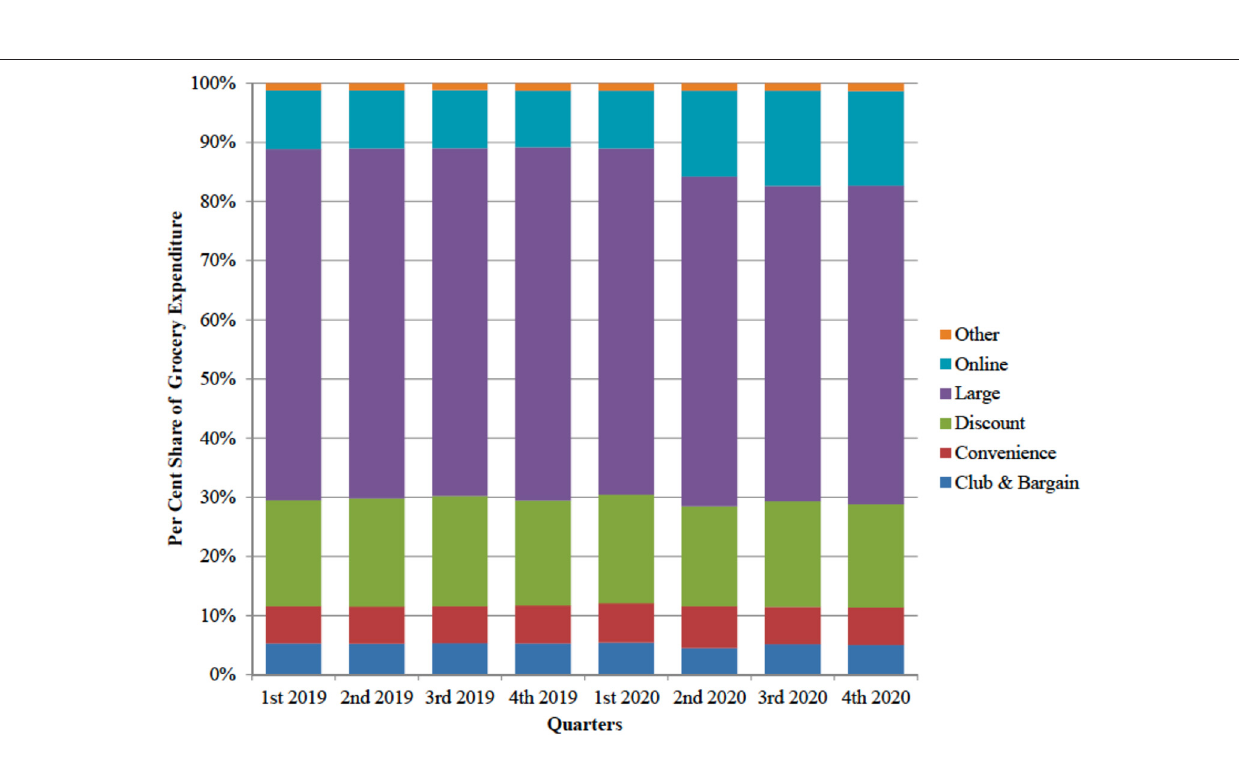
FIGURE 3 | Expenditure for all grocery goods by types of store (UK, per cent